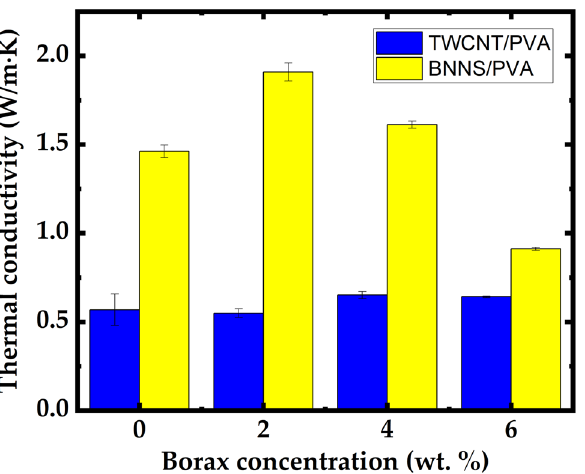
Figure 6. Comparison of the thermal conductivities of TWCNT/PVA and BNNS/PVA nanocomposite films obtained using different borax concentrations (2–6 wt.%).